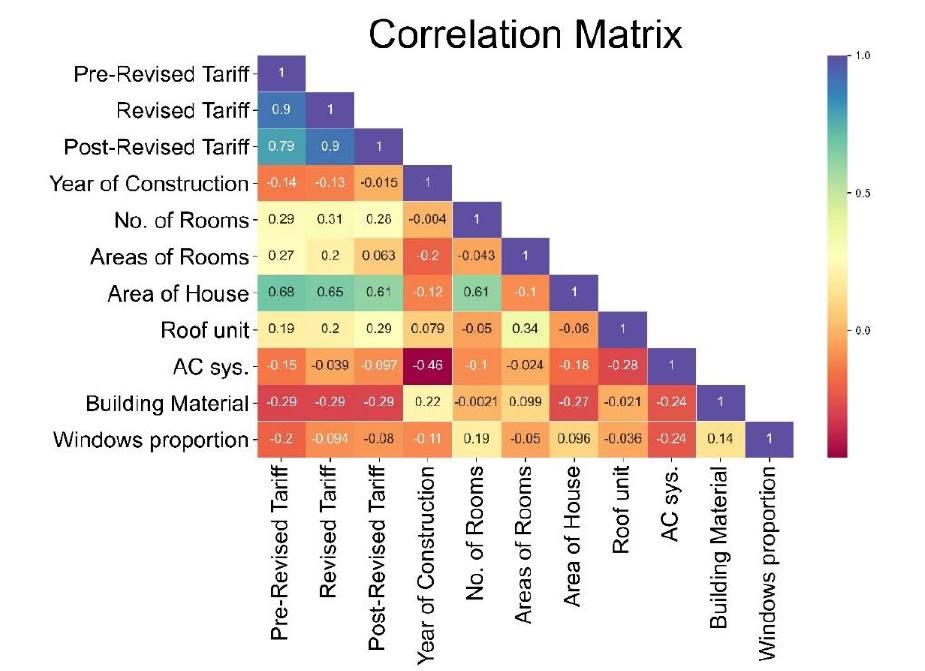
Table 9. Sensitivity analysis using the developed ELM: impacts of building attributes on the low, medium, and high usage clusters.